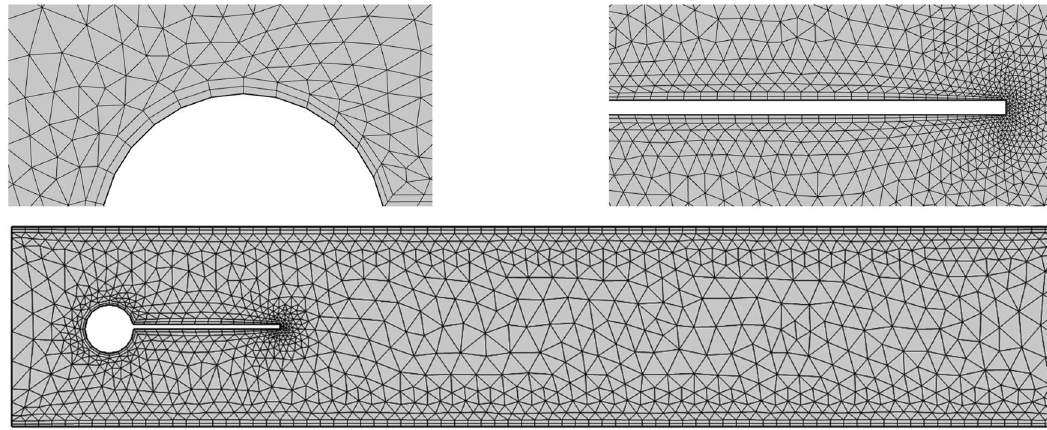
Figure 4. Hybrid mesh grid detail.